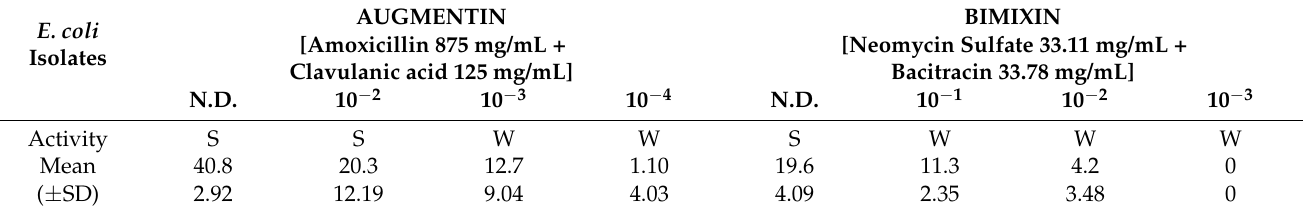
Table 5. Antimicrobial activity of two antibiotics commonly used on humans with respect to 23 E. coli isolates Data interpretation in Section 4.6. Here are reported the mean halo diameter calculated for each column ± SD according to Mazzarrino et al.